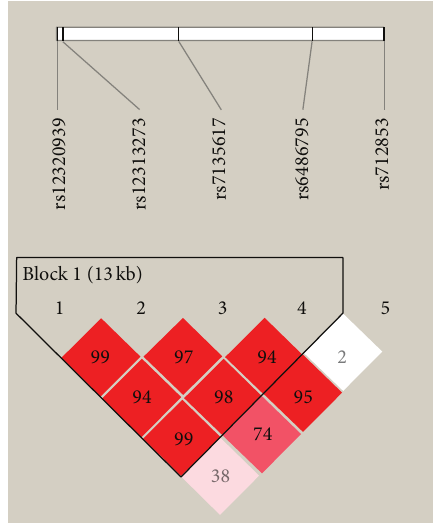
Figure 1: Five tSNPs on the LD map of ORAI1